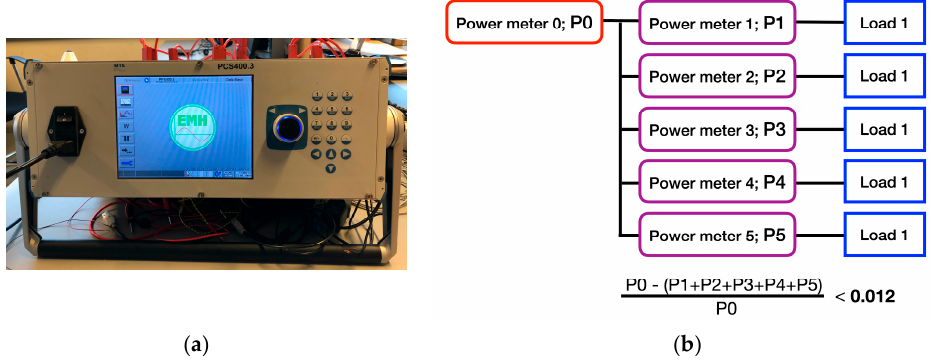
Figure 3. ( a ) Three-phase adjustable power source MTE PCS400; ( b ) accuracy field test